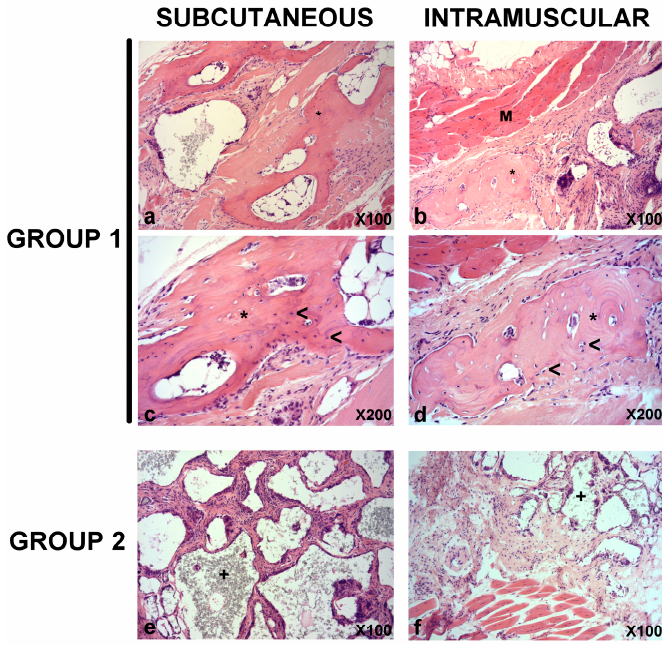
Figure 4. Representative images of subcutaneous and intramuscular constructs from Group 1 ( a – d ) and Group 2 ( e , f ) at week 9 after constructs implantation. While there was signs of formation of lamellar bone (asterisks) with signs of functional lacunae (presence of nucleus, head arrows) interspersed within the construct matrix in subcutaneous ( a , c ) and intramuscular ( b , d ) constructs from Group 1, in subcutaneous ( e ) and intramuscular ( f ) constructs from Group 2 there was a infiltration of connective tissue with trabecular disposition in which signs of a refringent material (+) could be identified within trabeculae. (M): Skeletal muscle. Hematoxylin and eosin (H&E) stain. Magnifications: 100 × ( a , b , e , f ) and 200 × ( c , d ).